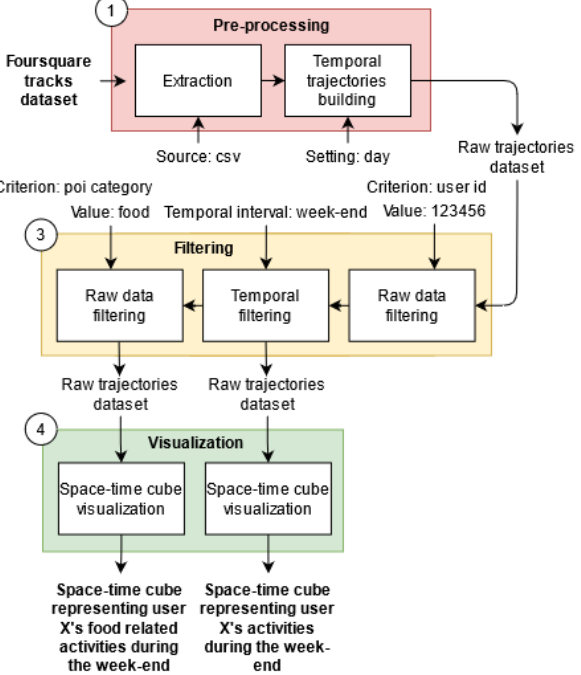
Figure 10. Customized processing chain to answer question